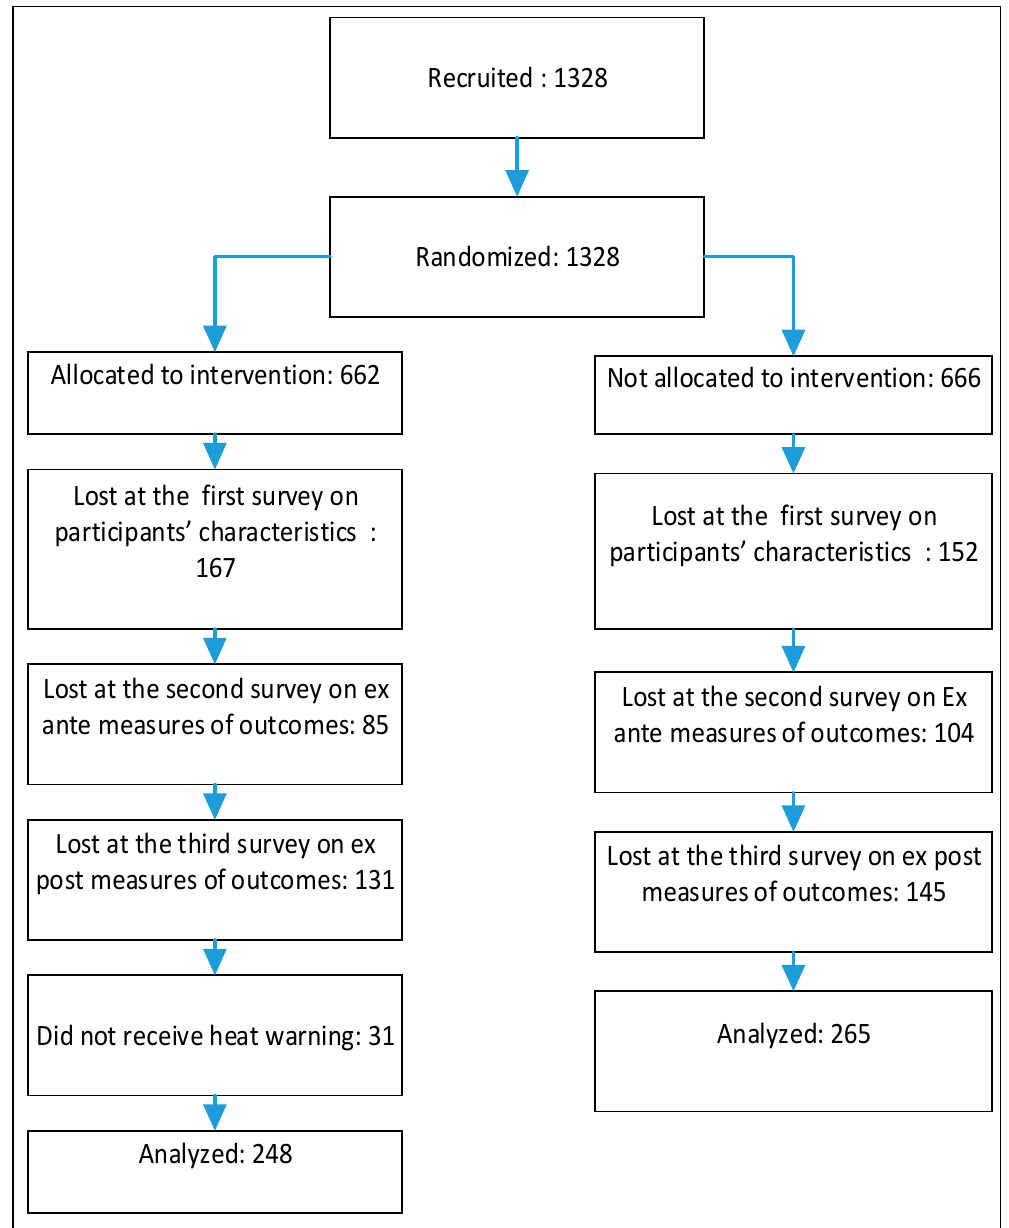
Figure 1. CONSORT Flow Chart of the Experiment.